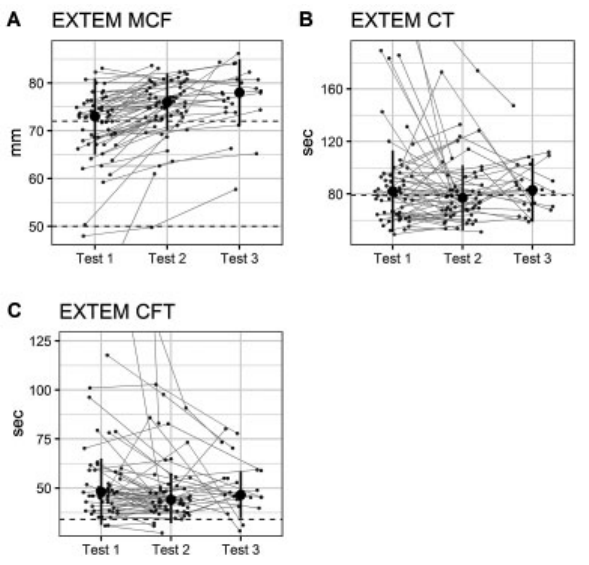
Fig. 2 LongitudinalROTEMdata.ROTEMsampledatinclusion,after5days andafter10days.In( A )EXTEM-MCF(dashedhorizontallinesareupperand lowerreferencevalues:50 – 72mm);( B )EXTEM-CT(dashedhorizontallineis upperreferencevalue:79second);( C )EXTEM-CFT(dashedhorizontallineis lower reference value: 34second). Median values reported with error bars representing IQR. For visualization purposes some outliers are not shown but are represented by lines connecting them to follow up measurements. Abbreviations: CFT, clot formation time; CT, coagulation time; EXTEM, extrinsically activated assays with tissue factor; IQR, interquartile range; MCF, maximum clot fi rmness; ROTEM, Rotational